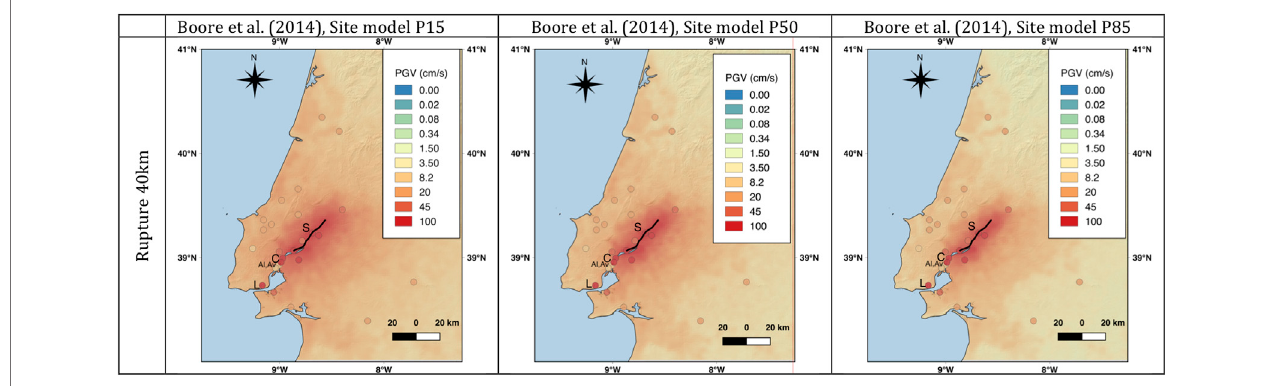
FIGURE 11 | Sensitivity of the PGV-based ground motion scenarios to site conditions. Locations for Santarém (S), Castanheira do Ribatejo (C) Alhandra (Al), Alverca (Av), and Lisbon (L), are included.